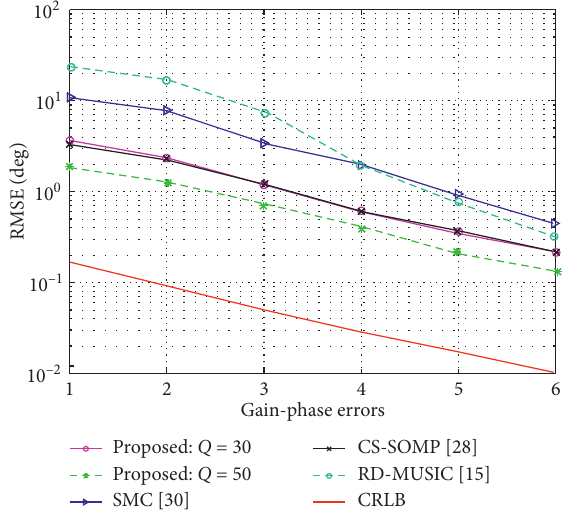
Figure 5: Angle estimation performance with varying gain-phase